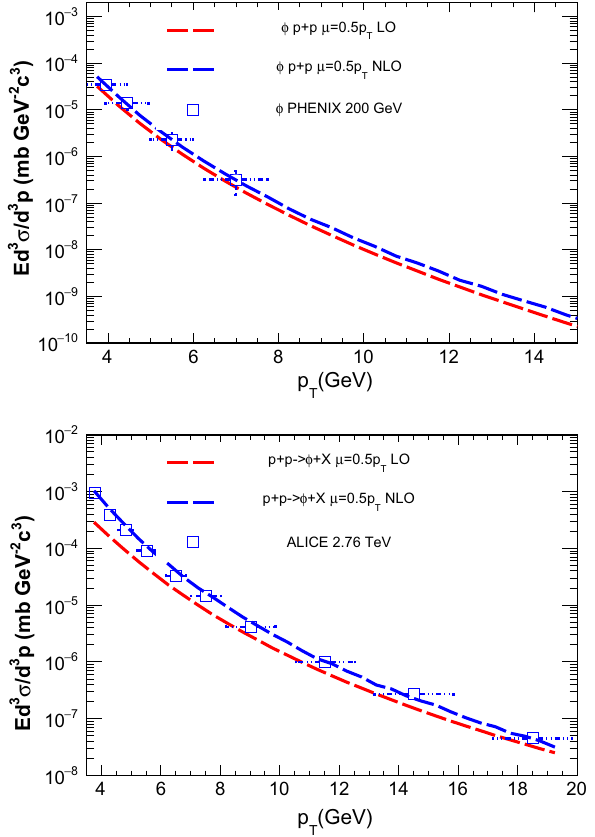
Fig. 3 Top Numericalcalculationofthe φ productioninp + pcollisions √ s NN = 200GeV at the RHIC with STAR data [16] ( σ NN = with 42 mb). Bottom Numerical calculation of the φ production in p + p √ s NN = 2 . 76TeV at the LHC with ALICE data [17,18] collisions with ( σ NN = 65 mb